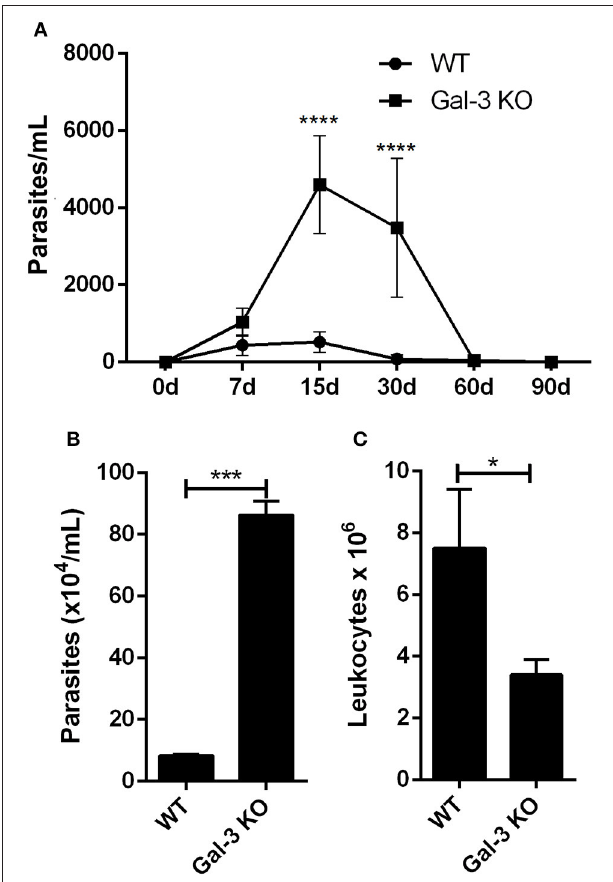
FIGURE 2 | Lack of Gal-3 leads to higher systemic parasitemia, delayed parasite clearance, and low leukocyte recruitment to the peritoneal cavity. Mice were inoculated intraperitoneally with T. cruzi CL strain trypomastigotes. At different time points post-inoculation parasitemia was measured in tail peripheral blood samples (A) . Parasites released (B) and leukocyte recruitment (C) to the peritoneal cavity was counted after 96h of infection. (A) Comparisons between groups were performed by Kruskal–Wallis and Dunn’s multiple comparisons test. * p < 0.05, *** p < 0.001, **** p <